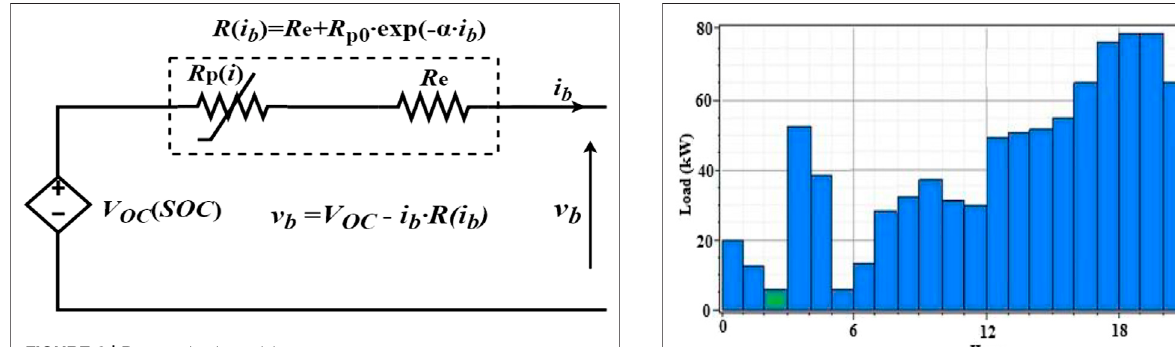
FIGURE 2 | Battery circuit model.